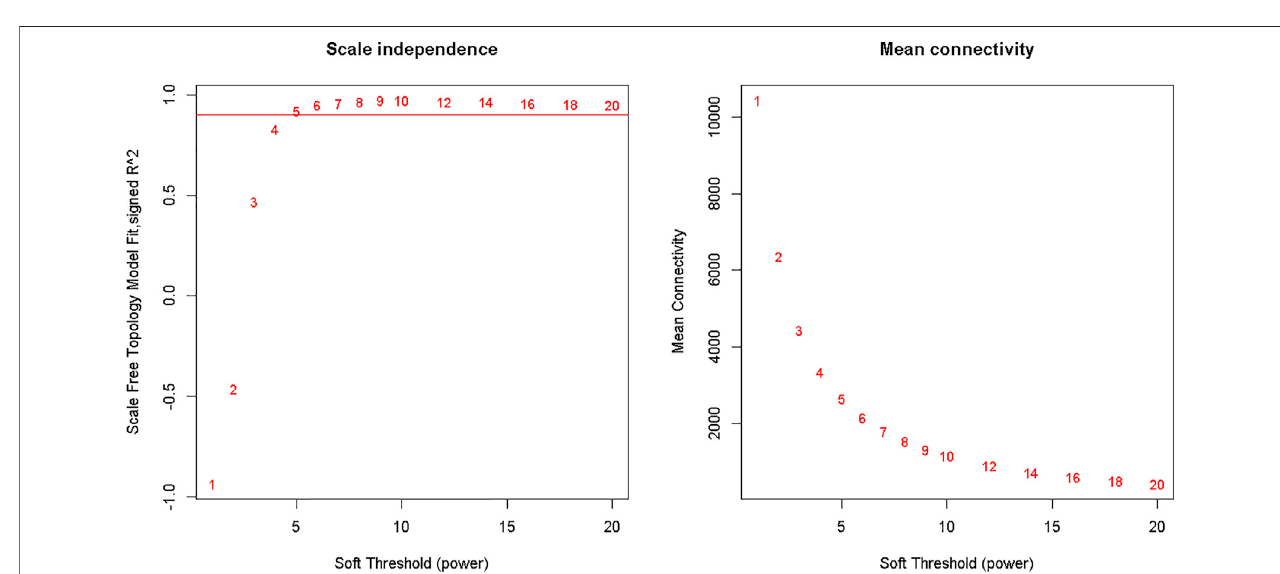
FIGURE 2 | Analysis of network topology for various soft-thresholding powers. The left panel shows the scale-free fi t index ( y -axis) as a function of the soft- thresholding power ( x -axis). The right panel displays the mean connectivity (degree, y -axis) as a function of the soft-thresholding power ( x -axis).